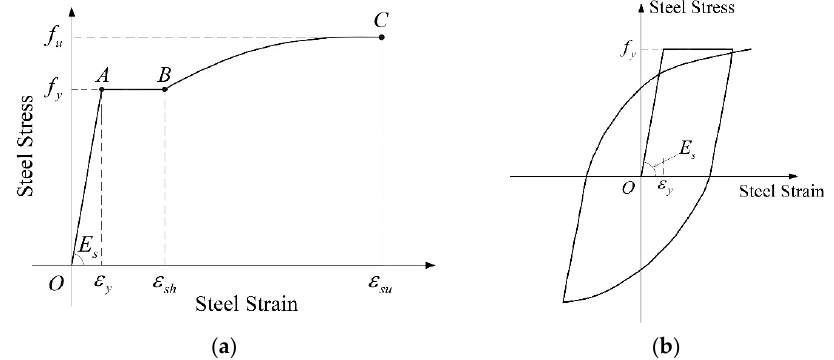
Figure 6. Park constitutive model diagram. ( a ) Stress–strain curve when loading. ( b ) Disposal strain curve, again when loading. Table 2. Mander constitutive parameters of pier fiber section concrete.